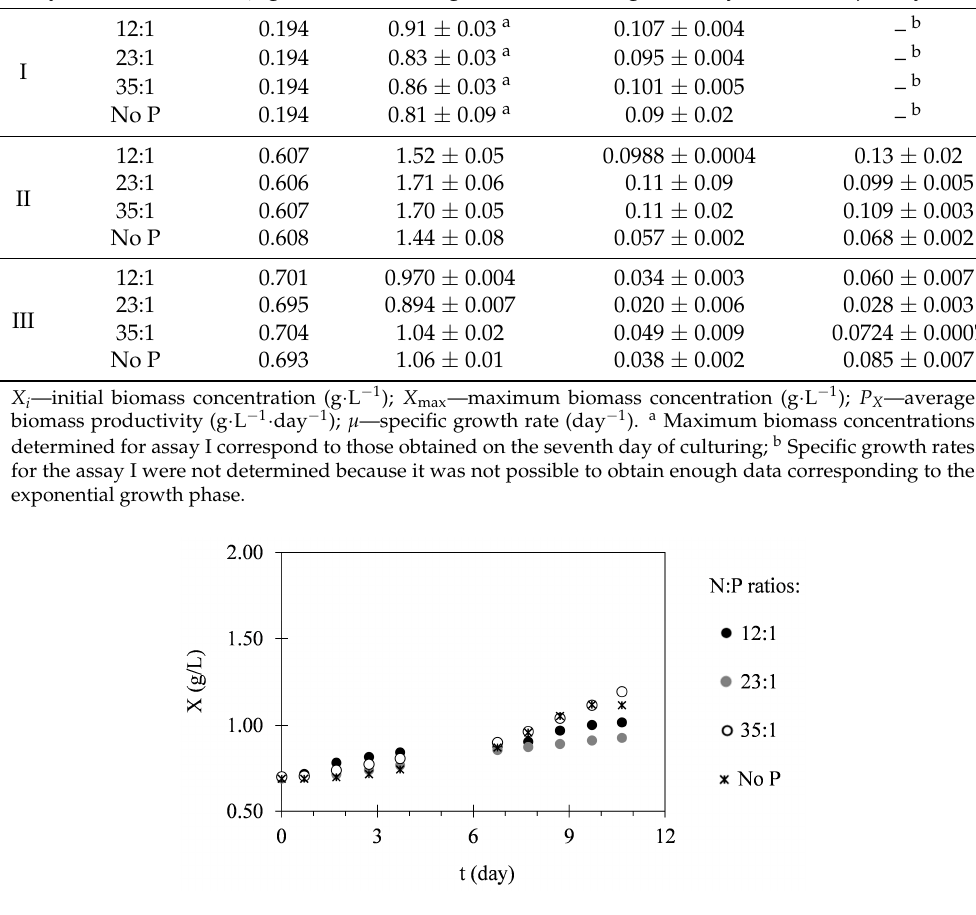
Figure 1. Temporal variation of biomass concentrations determined for assay III under different N:P ratios. The presented data correspond to the mean obtained from two independent experiments.